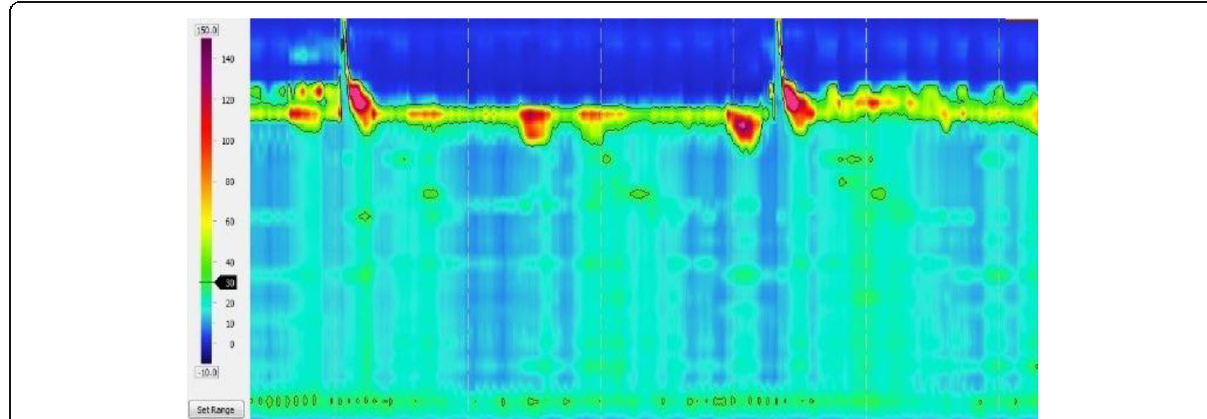
Fig. 6 HRM findings in Case 2. IRP was 15.7 mmHg, and the esophageal body had no contractility and was classified as type 1 achalasia according to